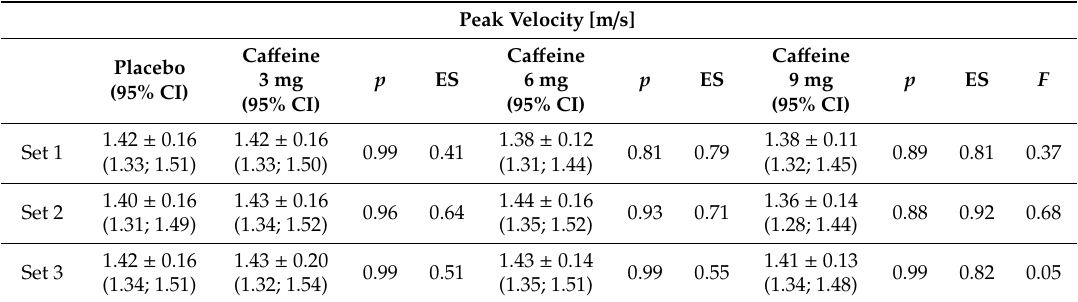
Table 4. Results of peak velocity in three successive sets of the bench press exercise in the group that ingested di ff erent doses of ca ff eine, and the placebo